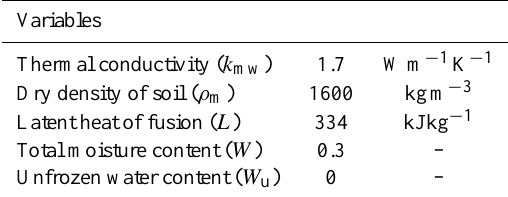
Table 1. Variable values applied in the Stefan equation.